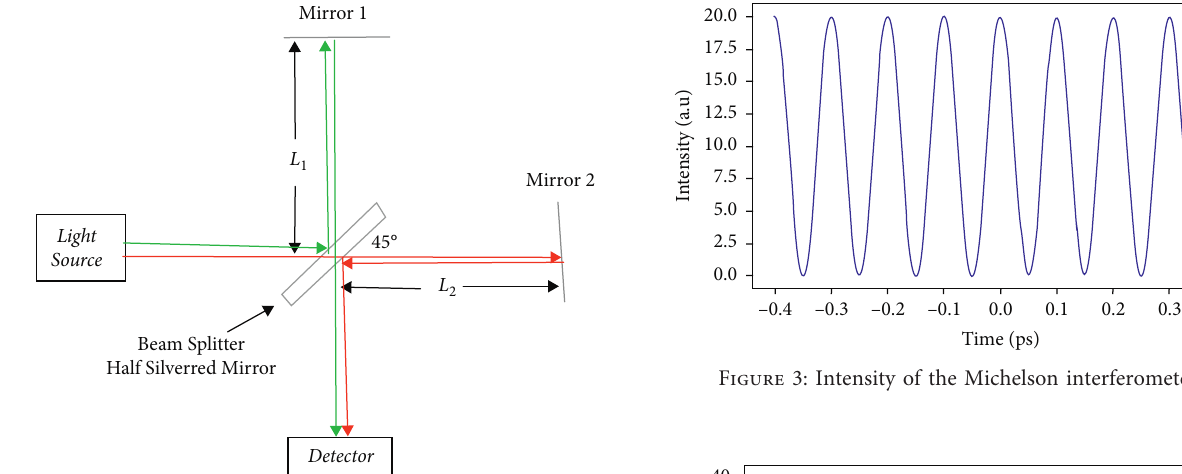
Figure 1: Schematic of the Michelson interferometer.